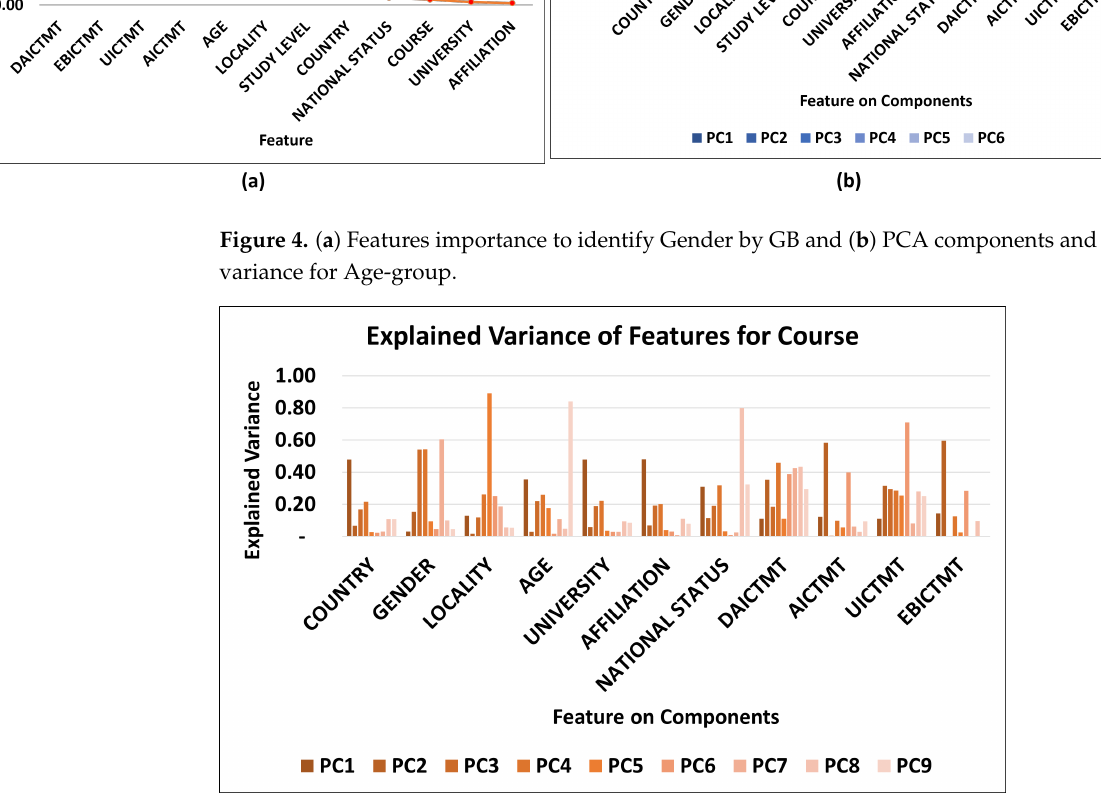
Figure 5. PCA components and Explained variance for